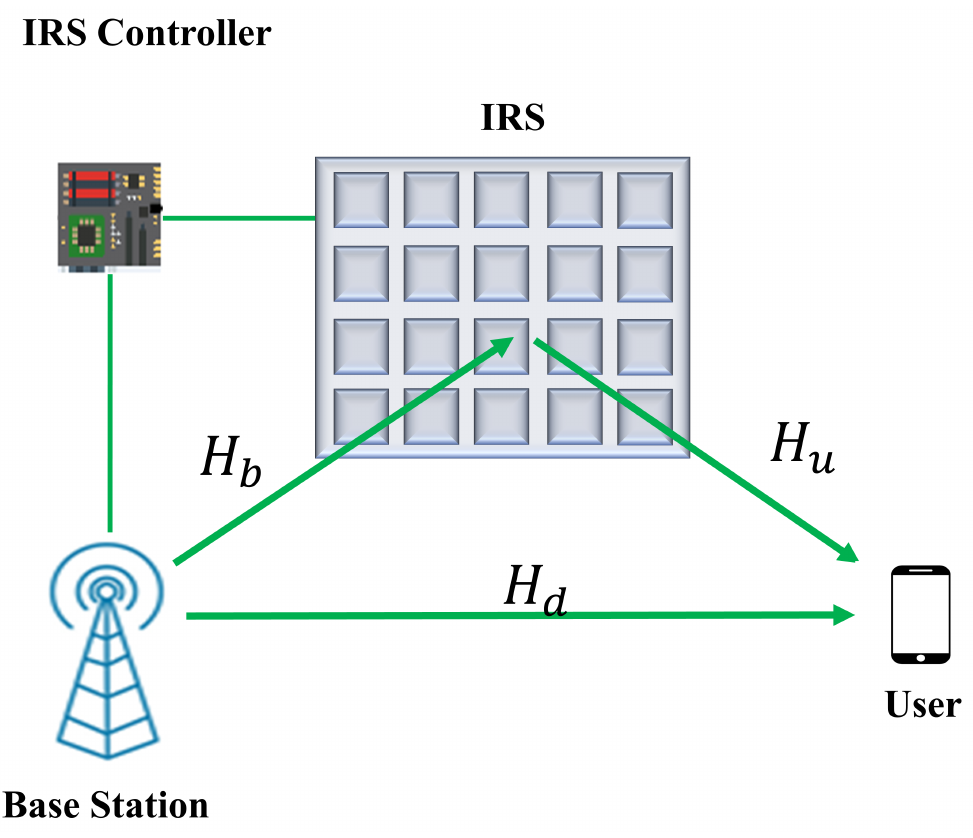
Figure 4. IRS-based communication model for base station to user link